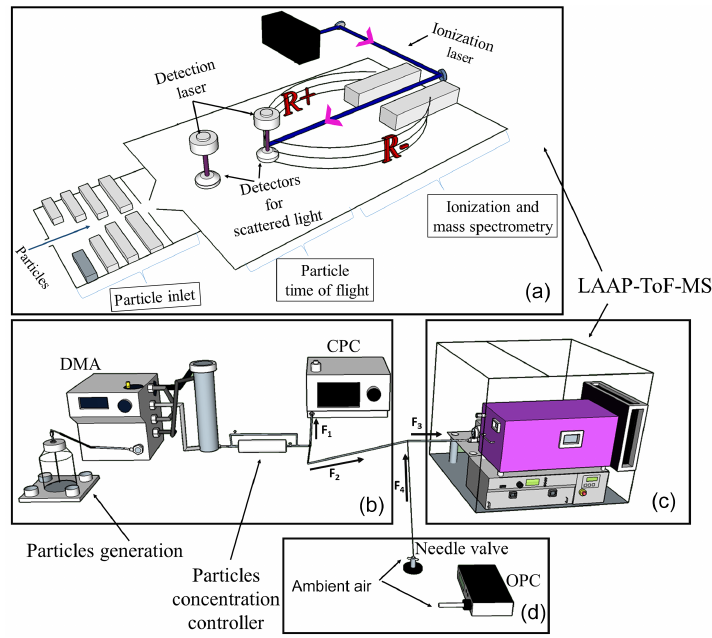
Figure 1. (a) Schematic diagram of the working principle of LAAP-ToF-MS, (b–c) Experimental configuration aimed to investigate the influence of particle density, size effect and detection efficiency, and (c–d) Experimental configuration for aerosol particle measurement.